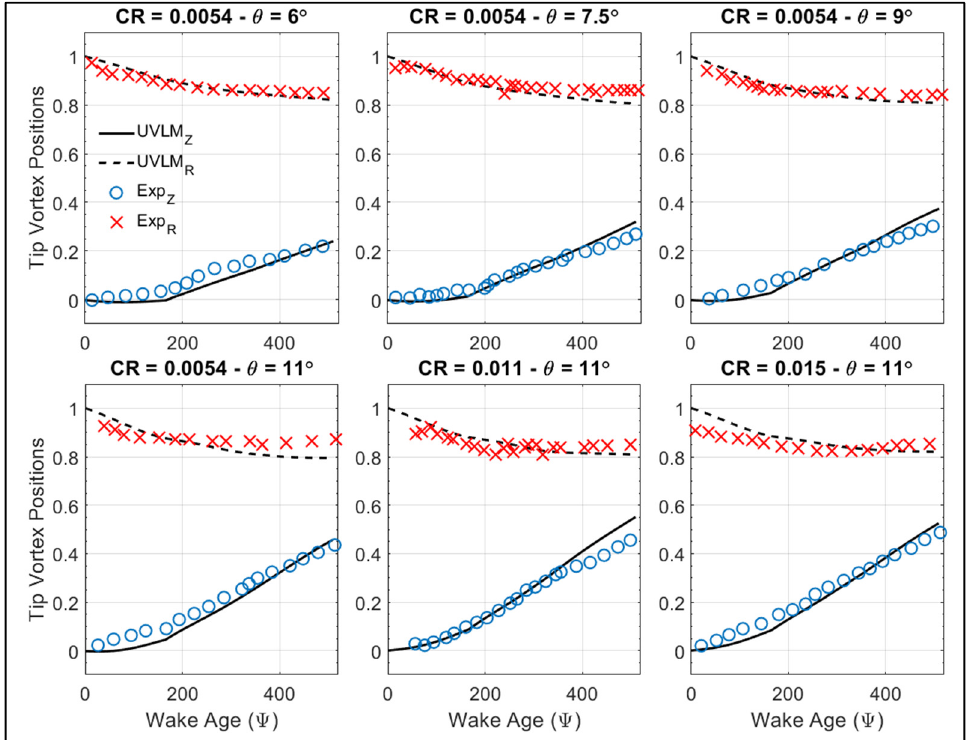
Figure 11. UVLM versus experimental radial and vertical tip vortex positions in axial flight.